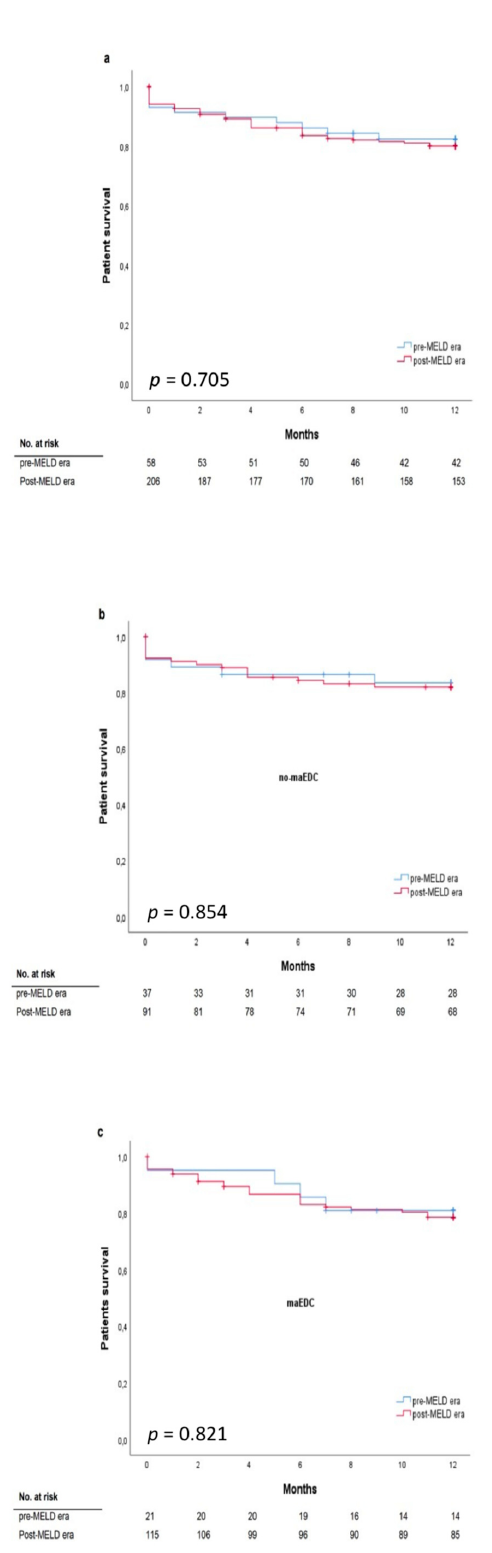
Figure 4. Patient survival does not significantly differ before and after establishment of model of end-stage liver disease (MELD) criteria in all patients ( a ), patients without maEDC ( b ), and patients with maEDC ( c ) (log-rank p = 0.705, 0.854, and 0.821).